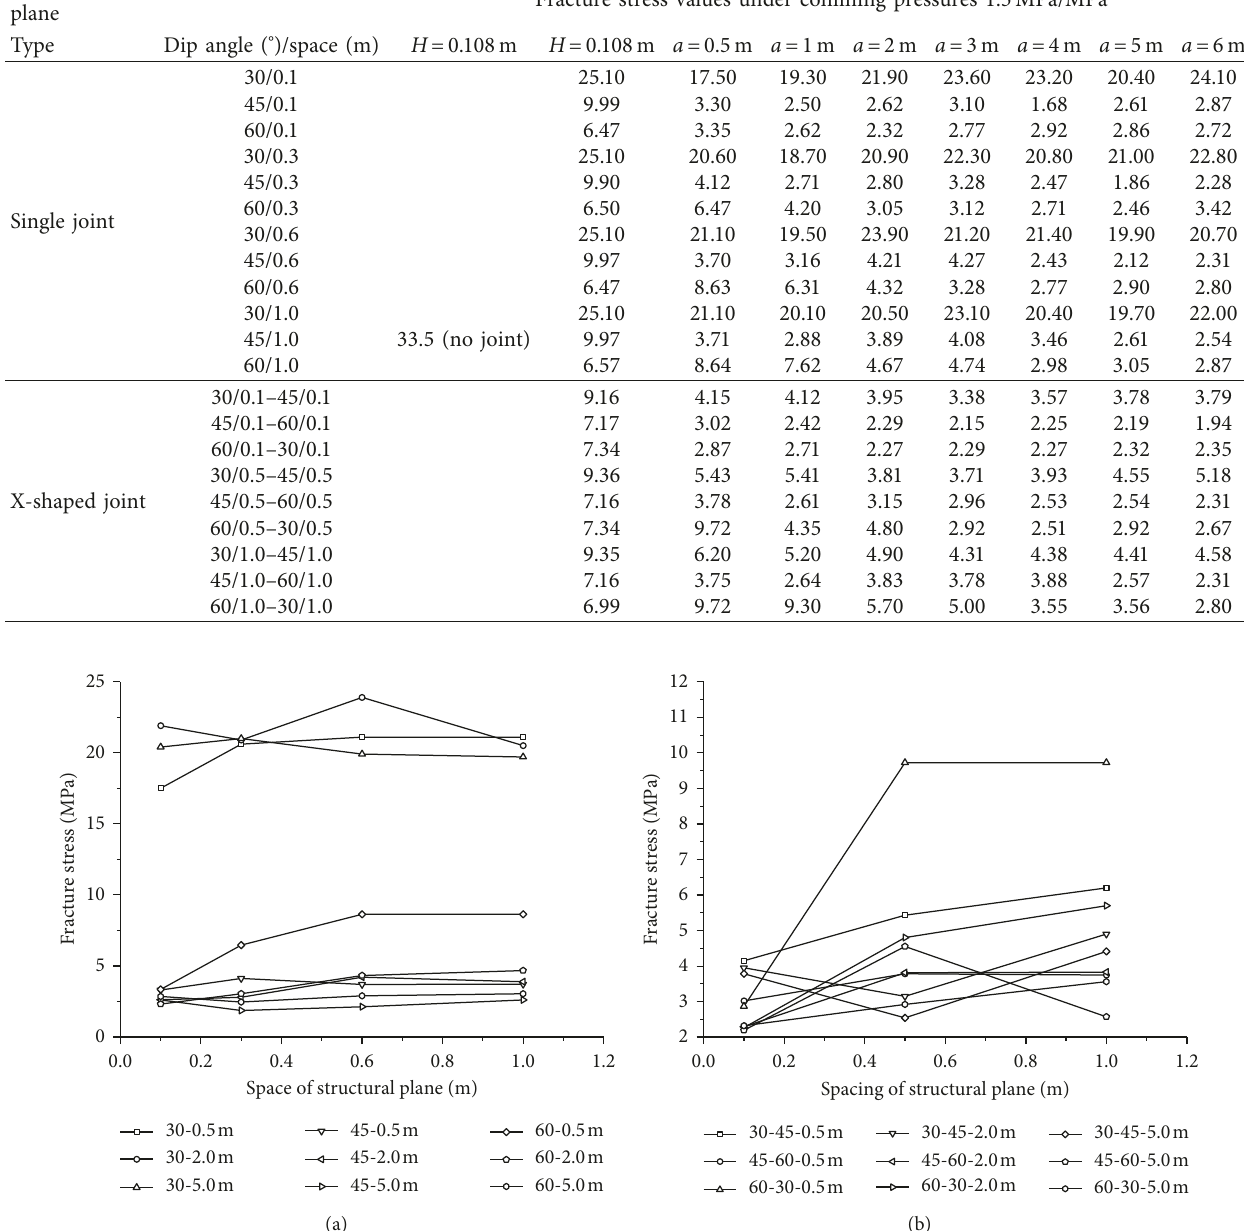
Table 3: Fracture stresses of rockmass with different dip angles and spacing when the confining pressure is 1.5 MPa ( a represents side length). Geometry characteristics of structure